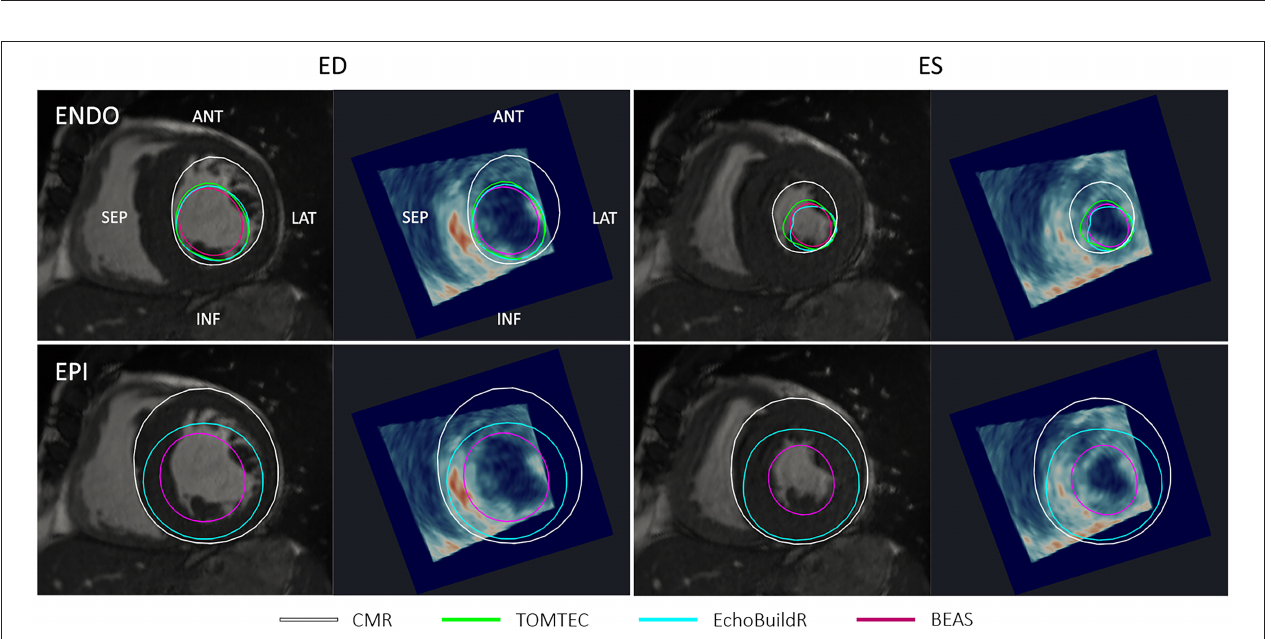
FIGURE 5 | Maximum intensity projections of short- (left) and long- (right) axis views of an example 3D-echo image volume from a healthy participant, showing typical dropout on the anterior surface. Arrows indicate regions of high signal (a) and low signal or dropout (b) . ANT, anterior; LAT, lateral; SEP, septal; INF, inferior.